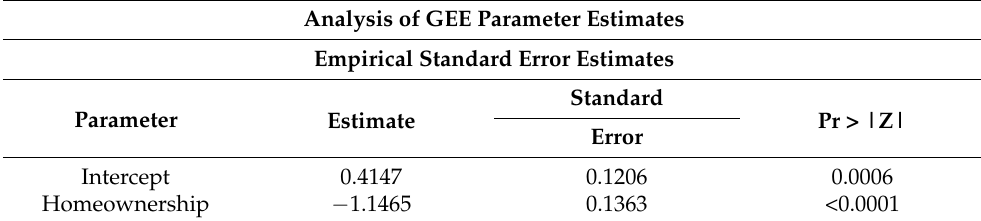
Table 2. Output of negative binomial regression representing the effects of homeownership on breaking and